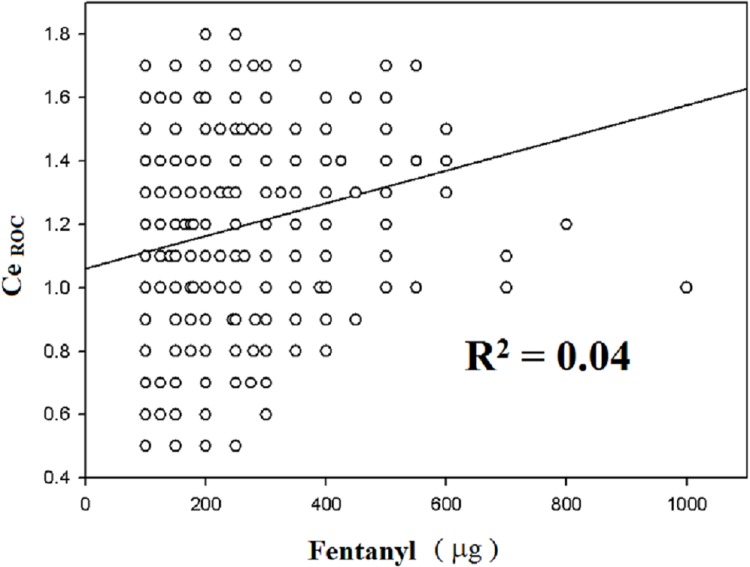
Linear regression between CeROC and consumption of fentanyl in 794 patients.Statistically significant correlation (R2 = 0.04; p < 0.01) and positive slope.